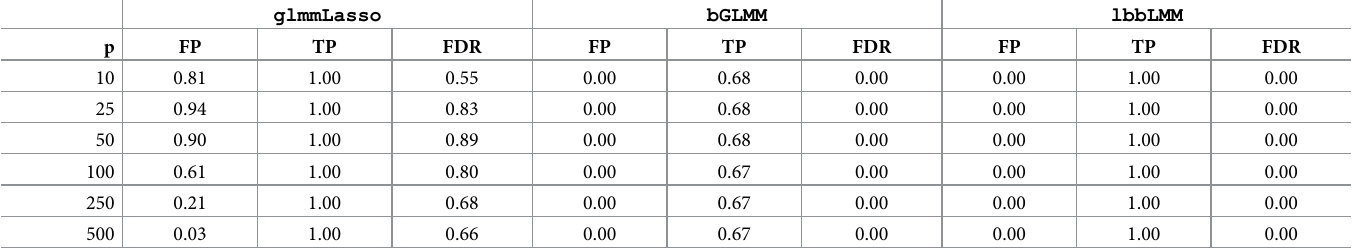
Table 6. Variable selection properties averaged over 300 runs for each p-dimensional random slopes setup. True positives (TP), false positives (FP) and false discovery rate (FDR). Since no noticeable variability regarding the choice of τ occurred, results are summarized. glmmLasso